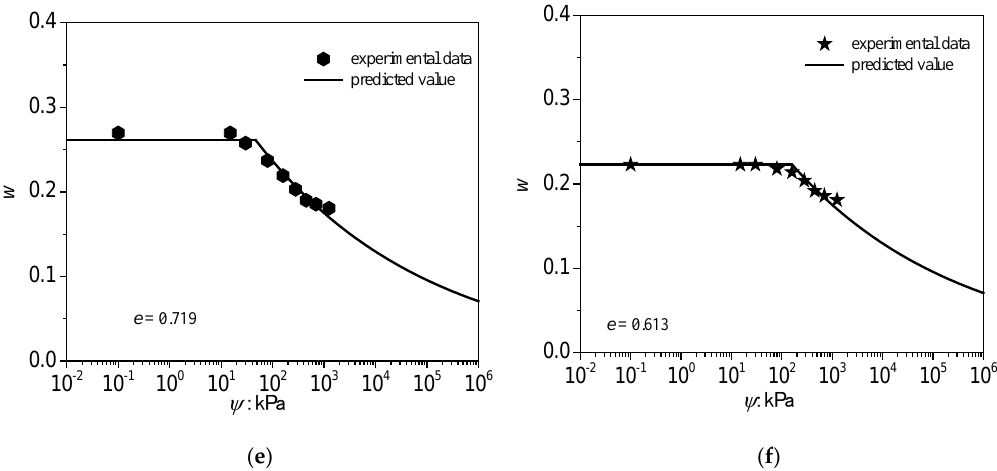
Figure 5. Measured and predicted SWCCs for Wuhan clay at deformed state at ( a ) e = 1.037; ( b ) e = 0.964; ( c ) e = 0.897; ( d ) e = 0.833; ( e ) e = 0.719; ( f ) e = 0.613.